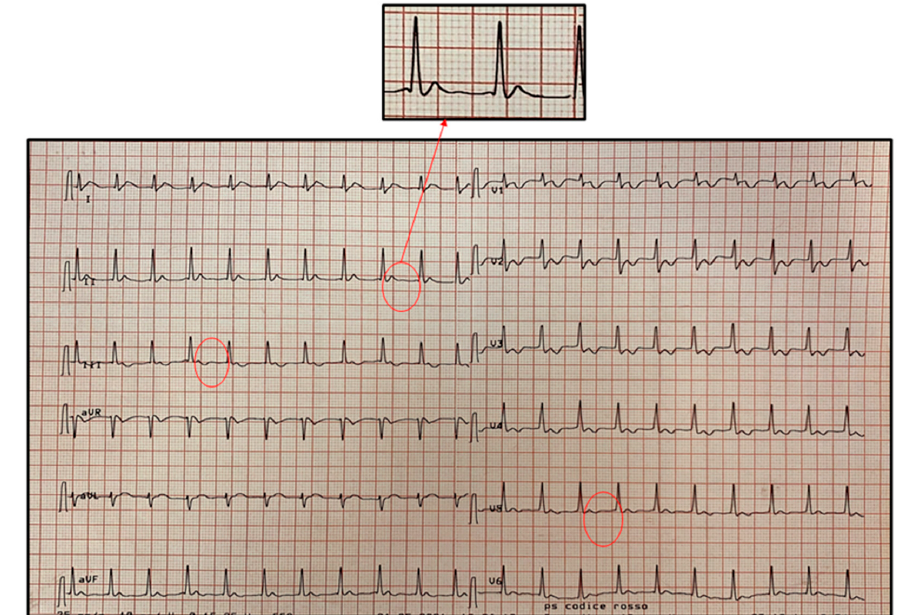
Figure 4. Atrial ectopic tachycardia (AET) at heart rate of 120 beats/min recorded on day 2 of hospitalization. The diagnosis is based on the presence of a regular narrow QRS complex tachycardia with an abnormal P-wave morphology originating from an ectopic focus. As shown in the magnification insert, the P-wave is not visible because it is morphologically different from the sinus one and it is fused with the preceding T-wave.